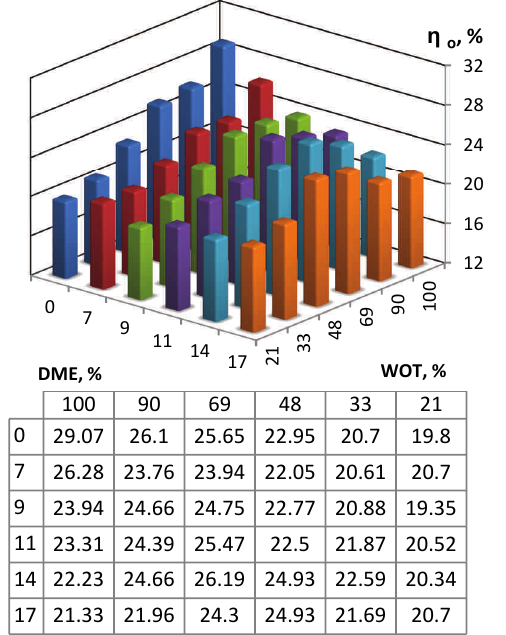
Fig. 20. Efficiency of tested engine in depend of DME share & engine load, n = 2500